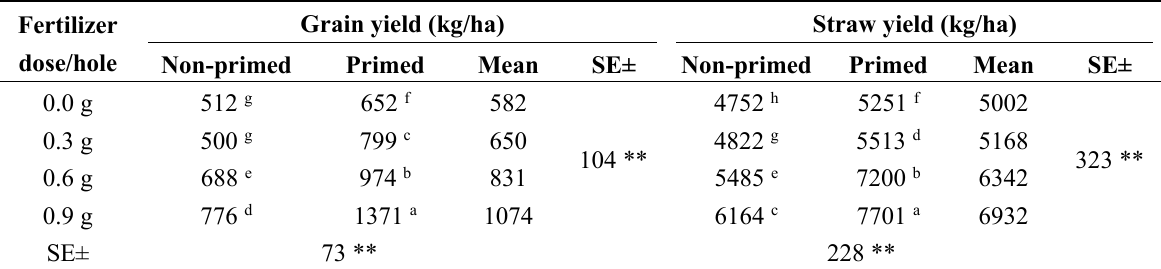
Table 3. Effect of seed priming and fertilizer micro-dosing on sorghum grain and straw yields (kg/ha) combined across two